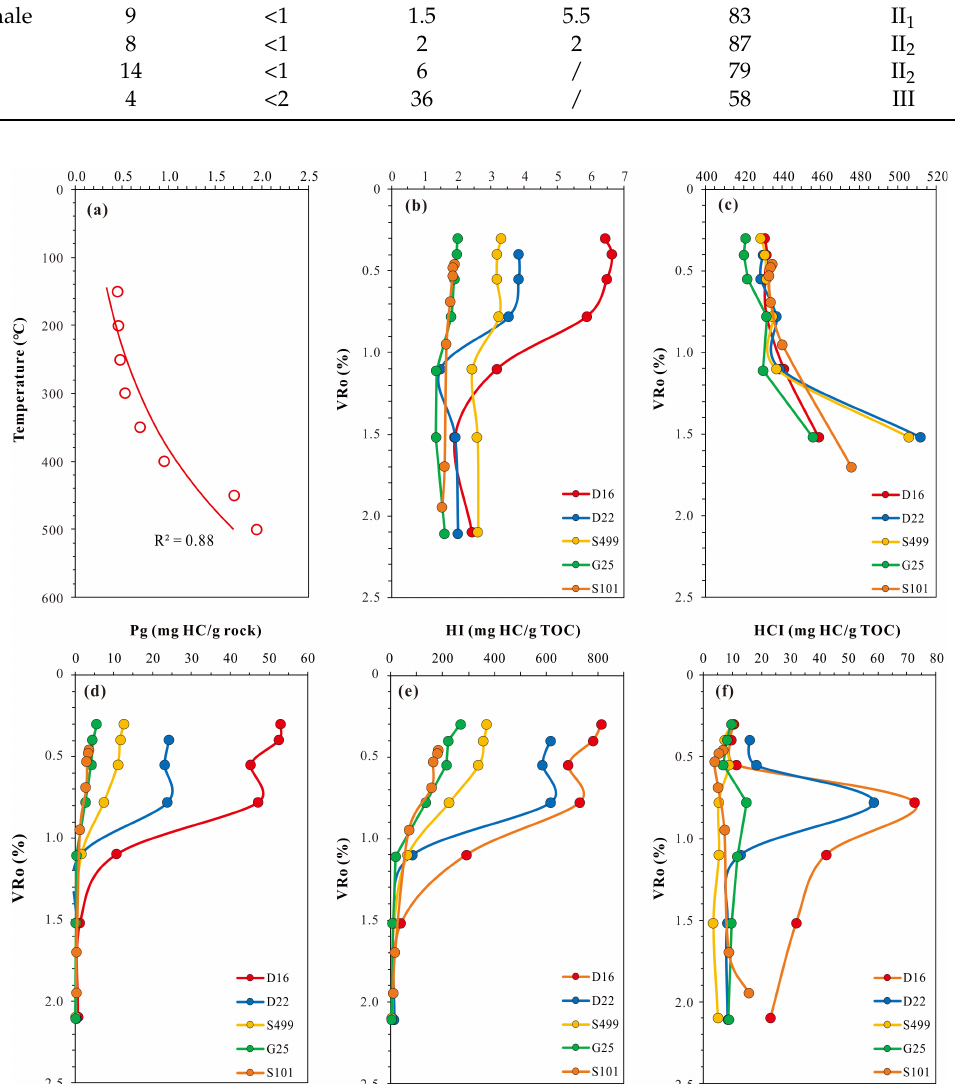
Figure 10. The evolution of geochemical parameters with increasing thermal maturity in the hydro- carbon generation simulation experiment. ( a ) Thermal simulation temperature vs. thermal maturity. ( b – f ) Geochemical parameters vs. thermal maturity.